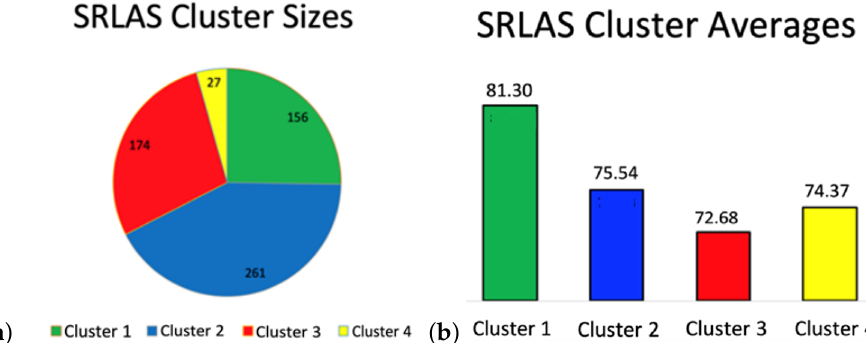
Figure 6. ( a ) SRLAS clusters’ sizes; ( b ) SRLAS clusters’ average final